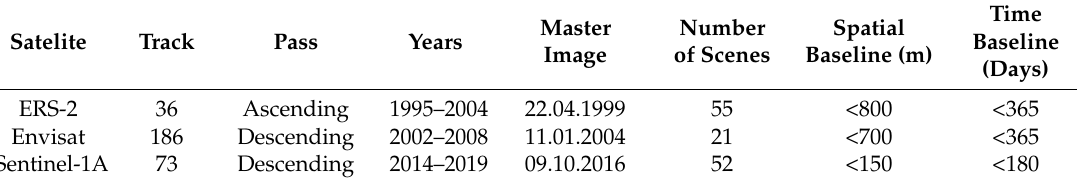
Table 1. Characteristic of the SAR data used in